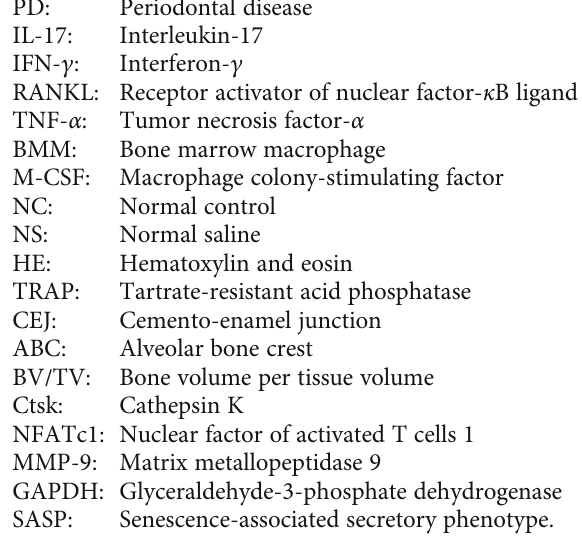
Figure S1: the number of TRAP-positive osteoclasts (A) and the area of TRAP-positive osteoclasts (B) were counted and presented ( mean ± standard deviation , n = 3 ). # p < 0 : 05 com- pared with the control group; & p < 0 : 05 compared with the IL-17+IFN- γ group. Figure S2: in condition 2, BMMs were cultured with M-CSF (30 ng/ml) for 3 days, and on day 3, 20 ng/ml RANKL together with IL-17 (1 ng/ml) or/and IFN- γ (0.2 ng/ml) was added for 5 days. The number